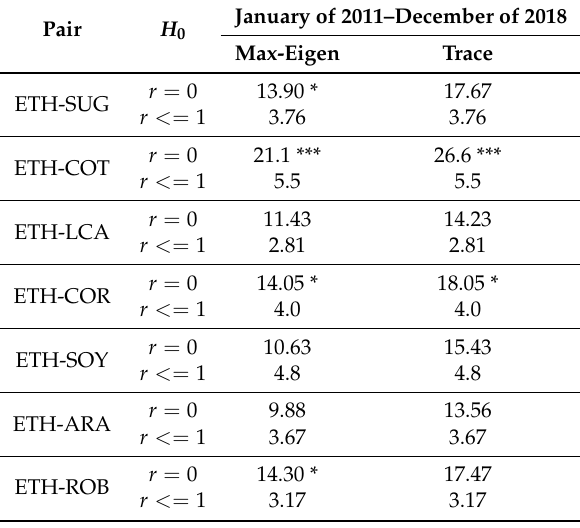
Table A1. The Johansen test for the full period. Significance levels: 10% (*), 5% (**) and 1% (***).